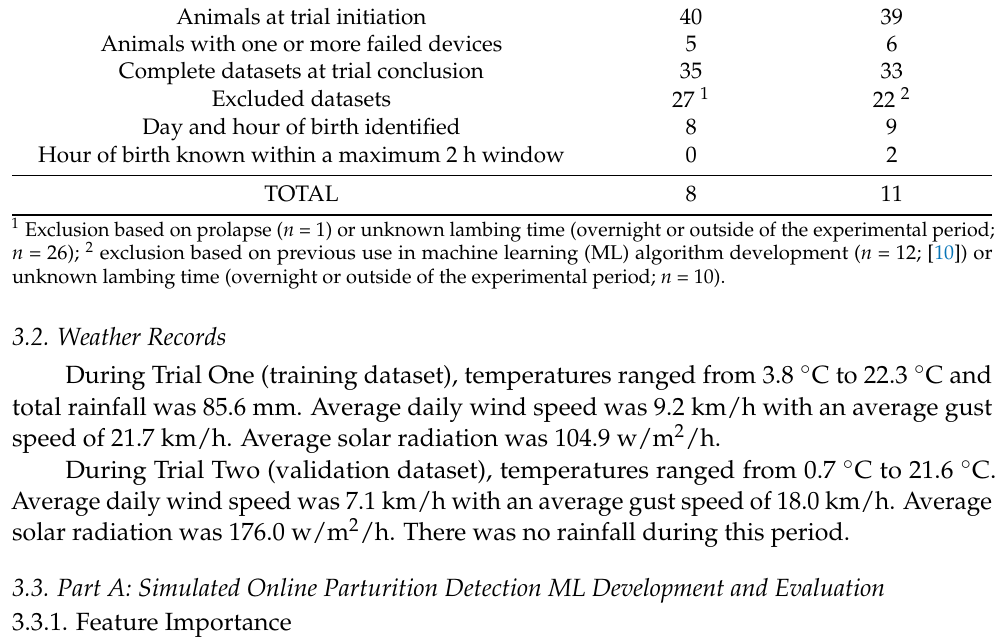
Table 2. Data and lambing records for the training (Trial One) and validation (Trial Two) datasets. Training Validation Animals at trial